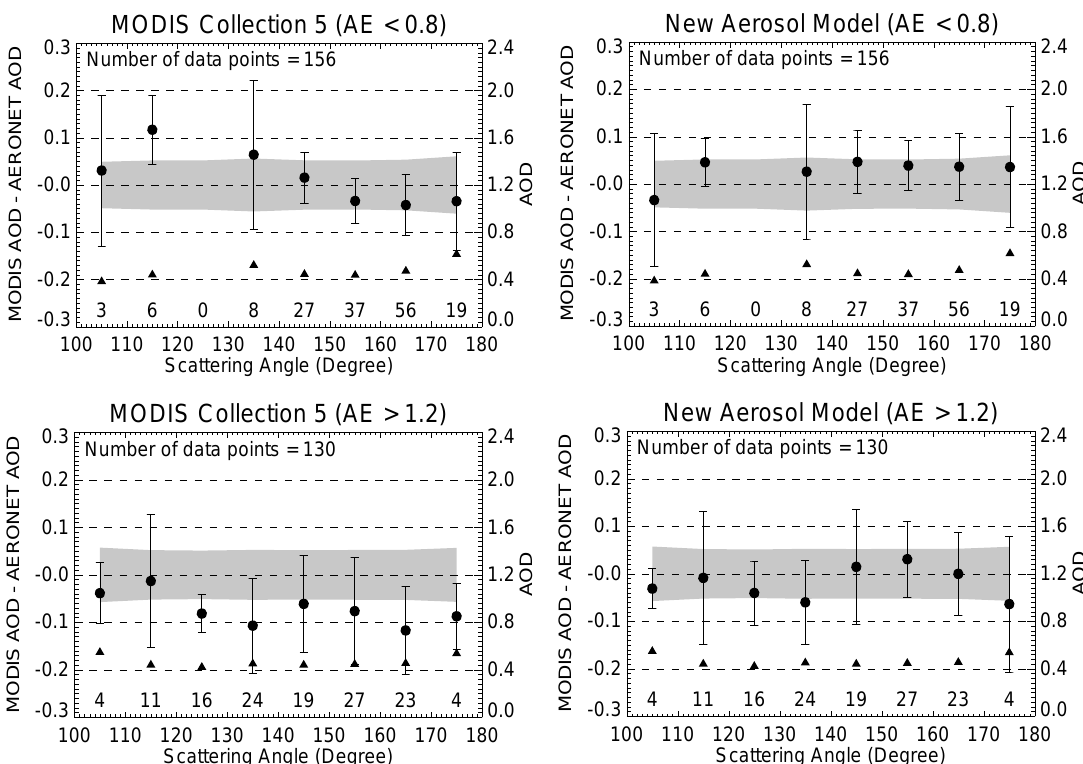
Fig. 9. Scattering angle dependence of the retrieval error for C005 algorithm (left) and test algorithm (right) for AE < 0.8 (upper) and AE > 1.2 (lower). Only data with AOD > 0.3 were used in this comparison. The symbols and lines are the same as those described in the legend to Fig. 7. Note that the data were sorted in each 10 ◦ interval of the scattering angle to highlight differences in the side-scattering-angle range (100–130 ◦ ) where the number of data points is low. The numbers on the x-axis represent the number of data points in each